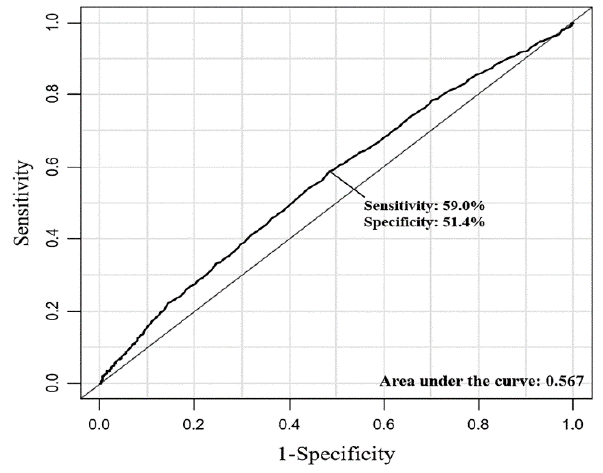
Figure 4. Receiver-operating characteristic plots to estimate the threshold of intraoperative blood glucose level associated with MINS. Table 4. Postoperative diagnosis in MINS patients.